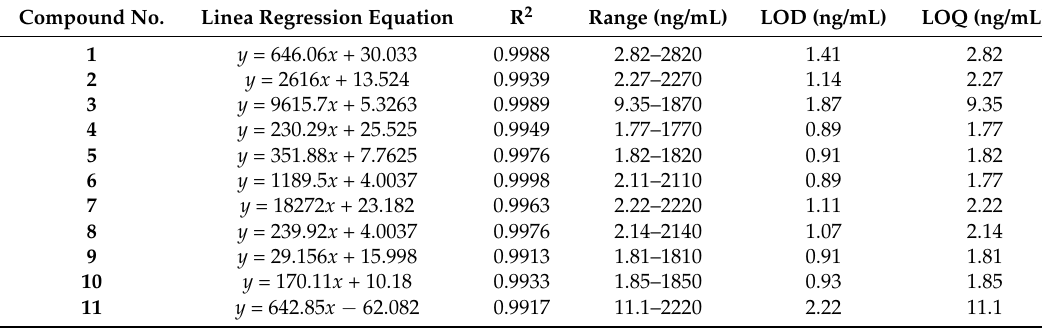
Table 2. The regression equations, linear ranges, LLOQs, and LODs of the eleven compounds. Compound No. Compound